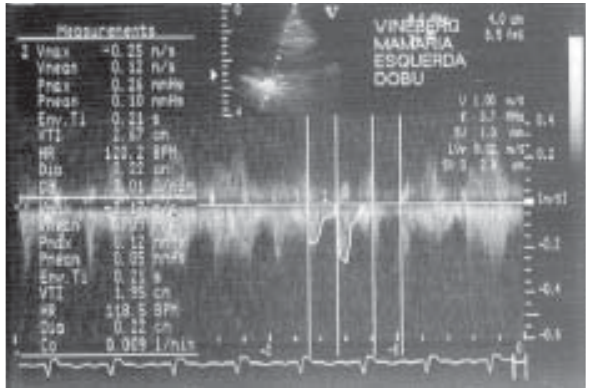
Fig. 1 - Echodoppler study of a left internal thoracic artery implanted in the muscles of the left ventricle. It is possible to see the bi-phase flow standard in the left internal thoracic